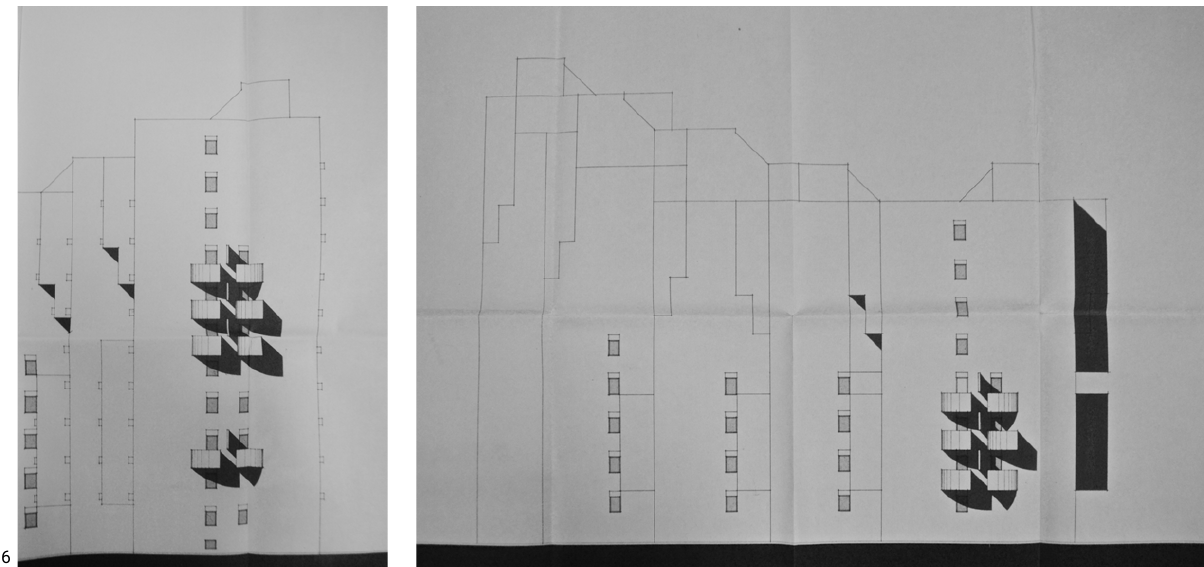
D3, north facade, 1978. (Source: State Archives of